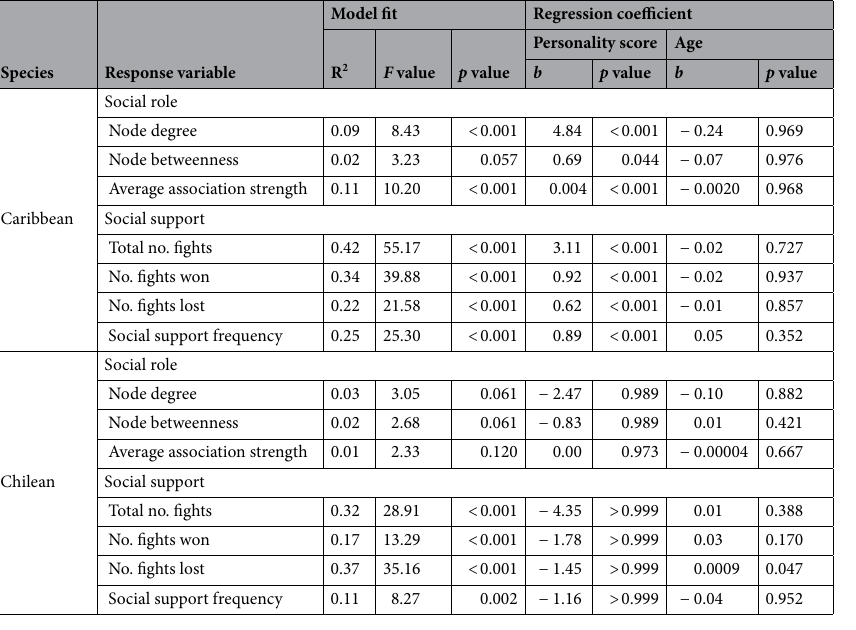
Table 2. Figures indicating individual model fit and predictor variable (personality, age) significance when modelled against measures of social role (node degree, betweenness and average association strength) and social support (total number of fights, total number won and lost, social support frequency) in the linear regressions with 1000 random permutation